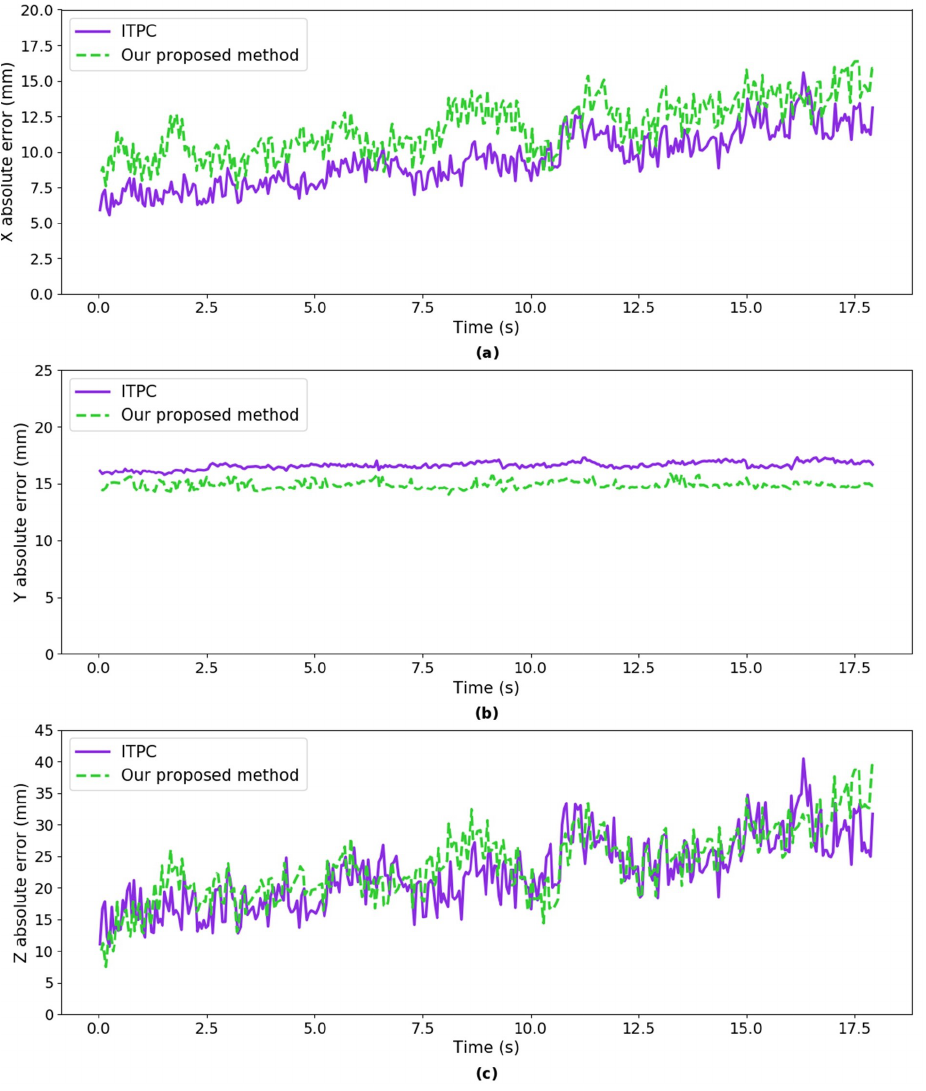
Figure 13. The absolute error of our proposed method and ITPC method w.r.t ground truth respectively. ( a ) absolute error in X axis; ( b ) absolute error in Y axis; and, ( c ) absolute error in Z